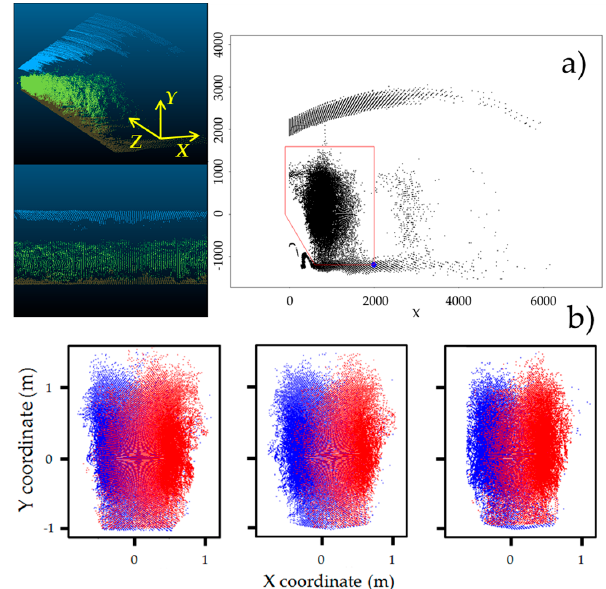
Figure 4. ( a ) LiDAR points cloud from one side in CloudCompare ® software with coordinate system and canopy delimitation procedure; ( b ) Plant delimitation process from twin plants (three replications).